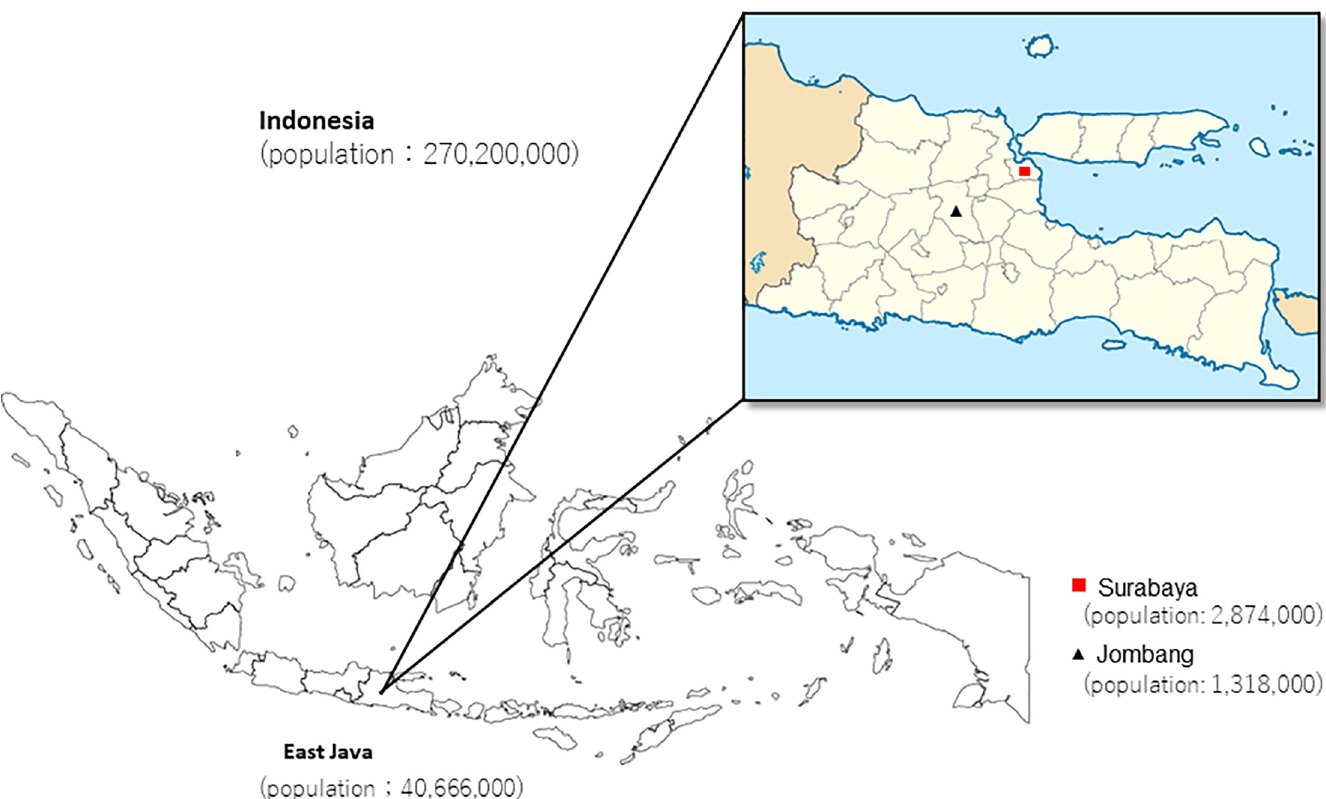
Fig 1. Geographic location of sample collection sites in this study. Map source: